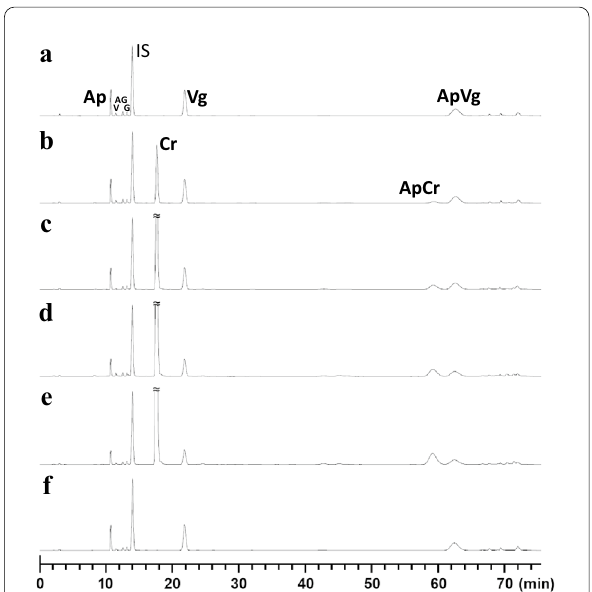
Fig. 5 HPLC chromatograms of the reaction solutions obtained at a reaction time of 120 min in systems Cr0’: a Cr10’: b , Cr25’: c , Cr50’: d